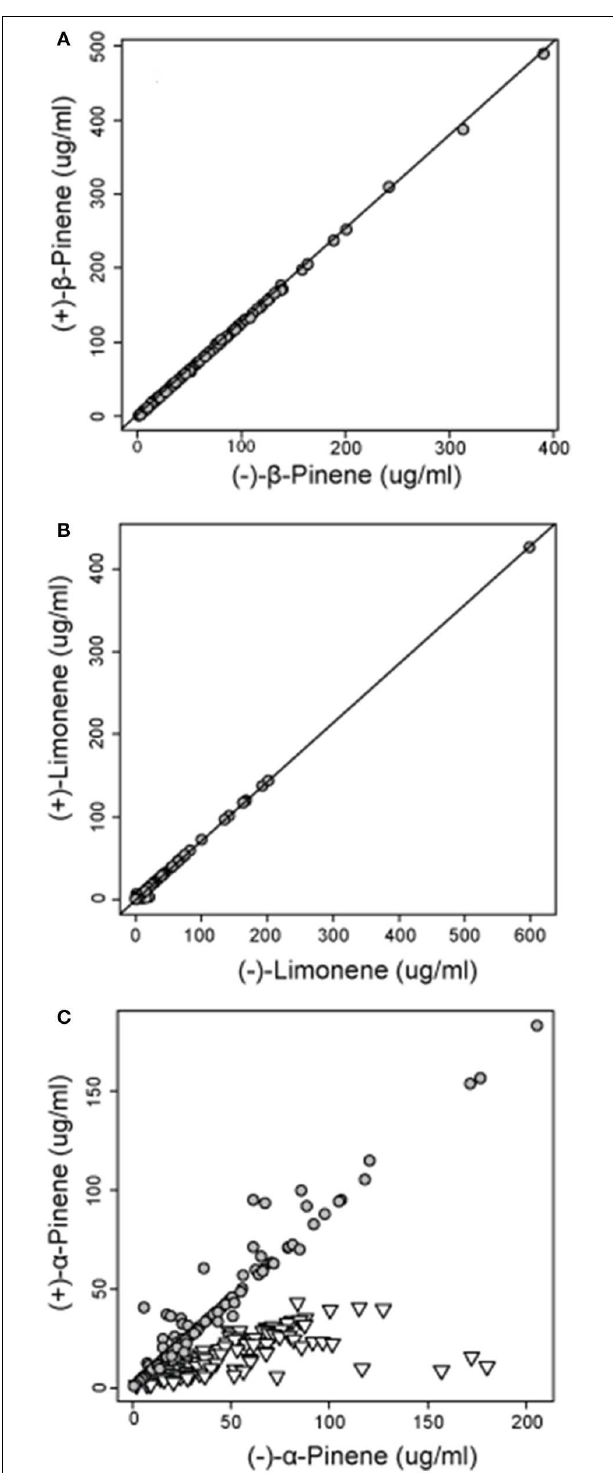
FIGURE 4 | Concentrations of (A) ( − ) and ( + ) β -pinene ( r = 0 . 999 ) and (B) ( − ) and ( + ) limonene ( r = 0 . 999 ) in natural jack pine ( Pinus banksiana ) stands plotted against each other to illustrate the relative amount of each enantiomer. For concentrations of (C) ( − ) and ( + ) α -pinene, gray circles represent group 1 and inverted triangles represent group 2, both as defined by a hierarchical cluster